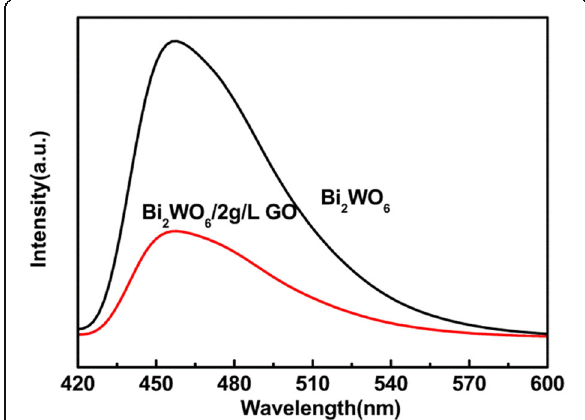
Fig. 6 PL spectra of the Bi 2 WO 6 and Bi 2 WO 6 /2 g/L GO deposited PET fabric (excitation wavelength:405 nm)